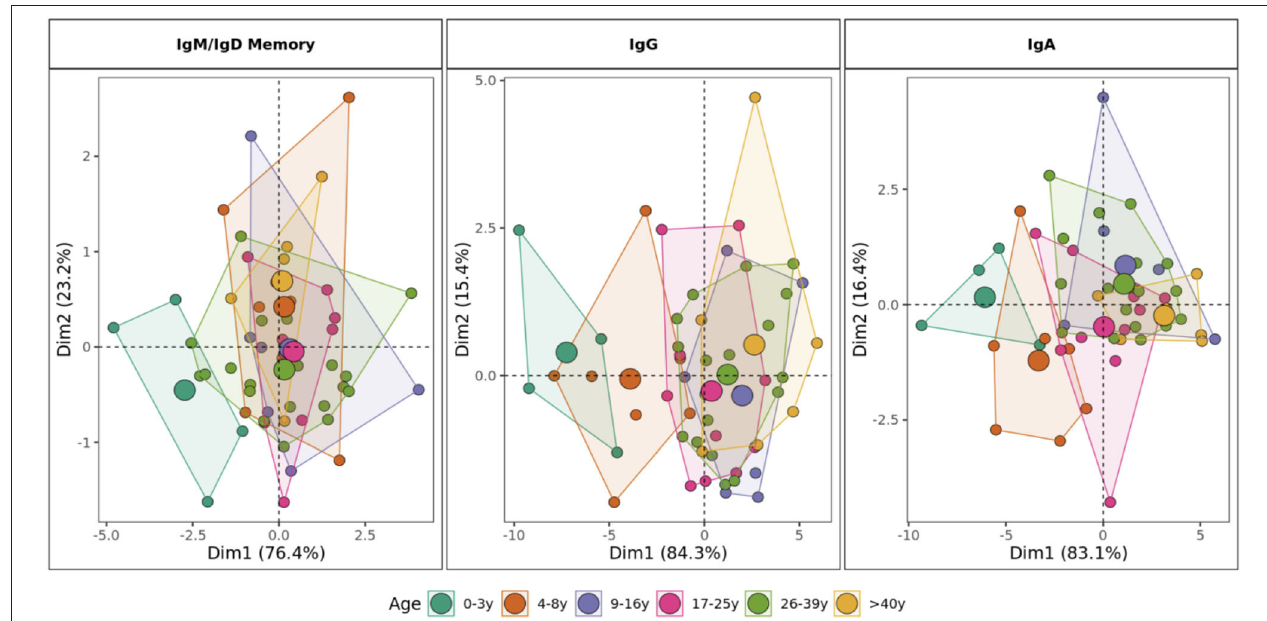
FIGURE 8 | Stratification of IgH repertoires by age group. Principal component analysis by age category including mutation number, R/S ratio, V1 gene family usage, J6 gene usage, junction length and proportion of sequences structurally divergent from germline as variables. For class-switched IgG and IgA, the proportion of IgG2 and IgA1 are included, respectively. Areas are the convex hulls of the age group and the largest point of one color represents the center of that hull. and p = 0.0036, respectively; p = 0.1800 for IgM/IgD memory; Kruskal–Wallis